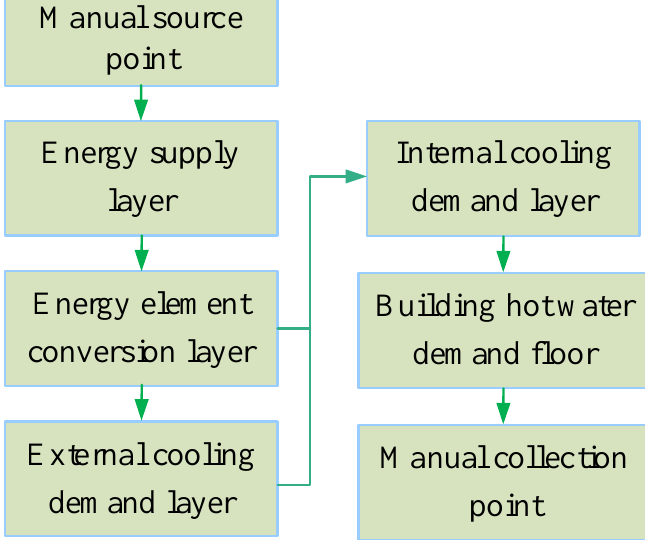
Figure 4. Regional energy planning model.